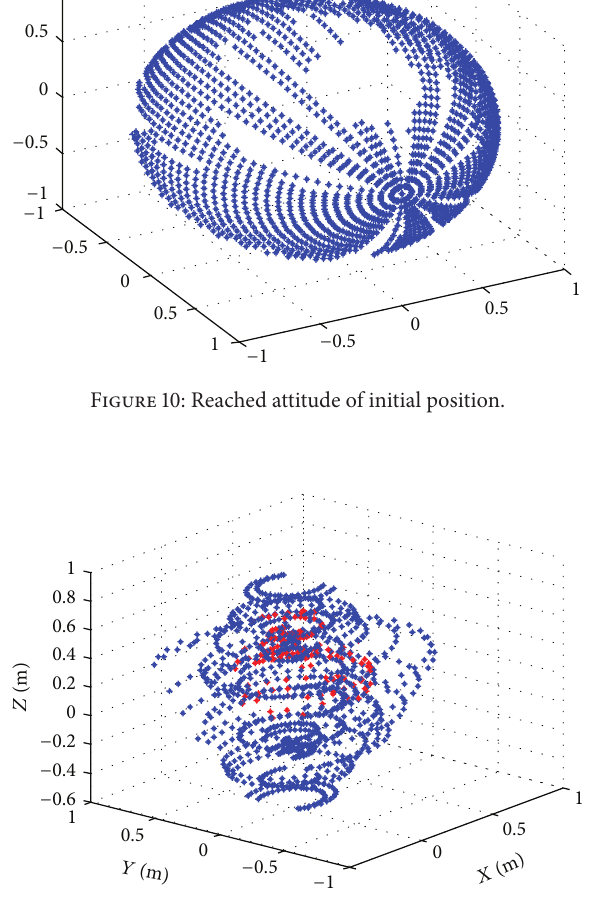
Figure 11: Attainable space and Omnidirectional space.